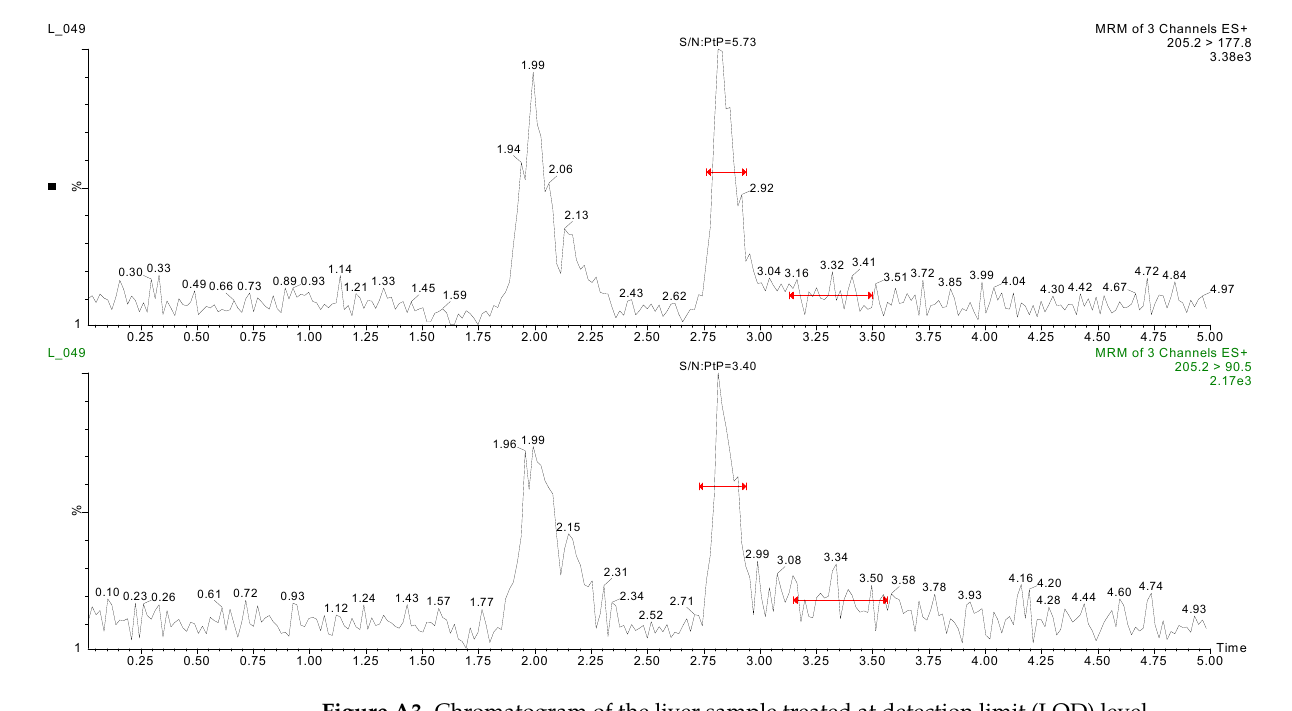
Figure A2. Chromatogram of the liver control sample.